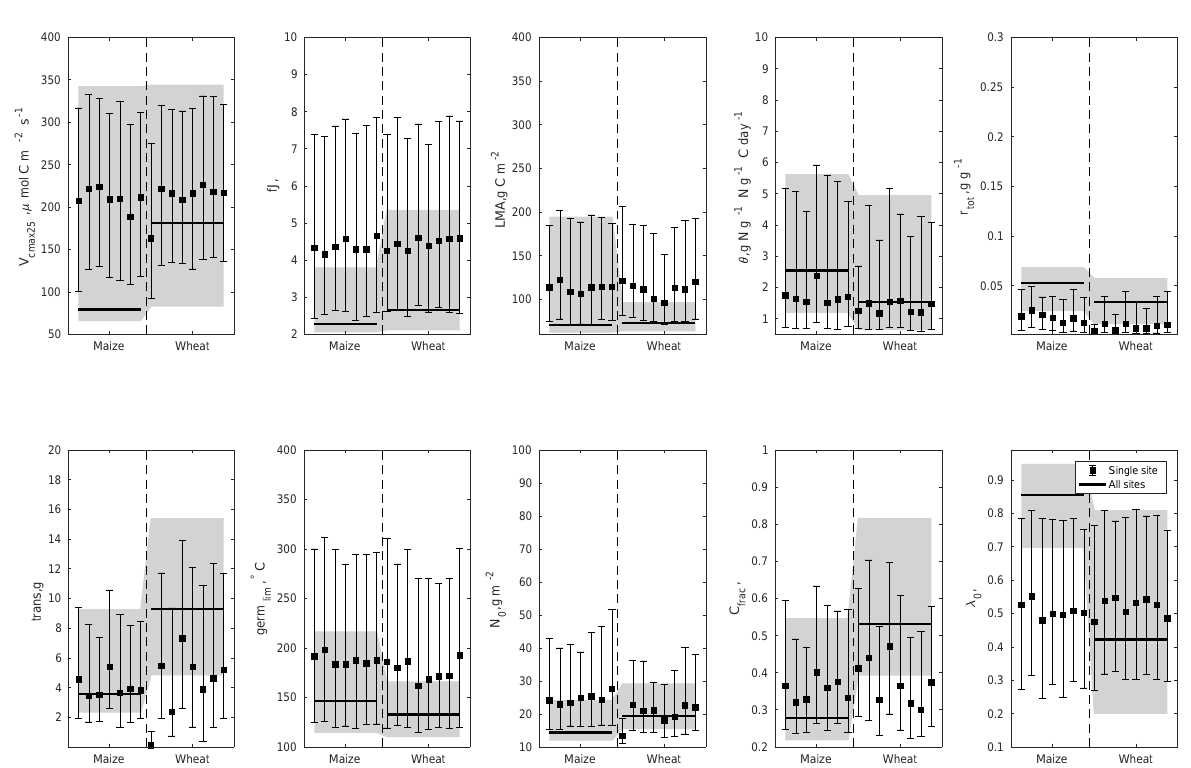
Figure 2. Estimated model parameters for all sites, fitted to individual locations (circles) and all locations combined (black line). Values are posterior medians, and error bars and shaded areas represent 95th percentiles of the posterior parameter distribution for the one-site and all-site parametrisation,